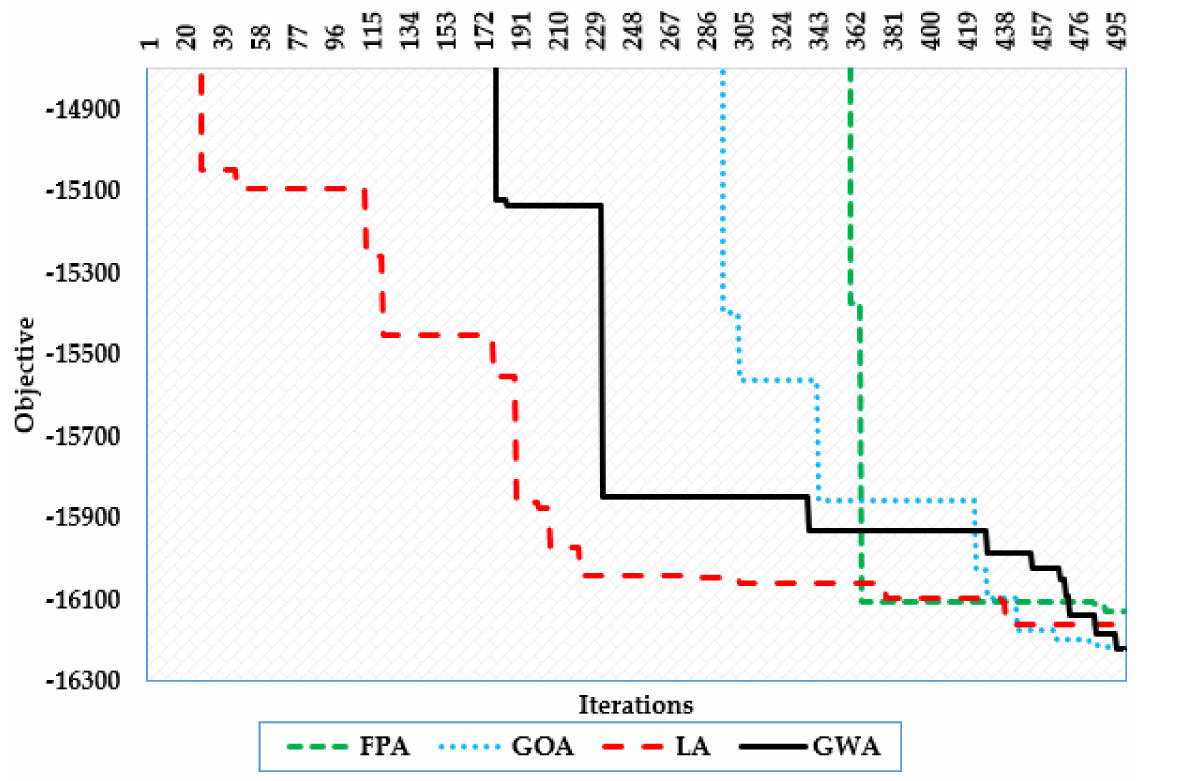
Figure 8. Best Convergence curves of GWA, FPA, LA, and GOA for TLSM design under second case. As shown, the GWA reaches the lowest value of 16,217.9 N for the flux saturation, while the FPA, LA, and GOA achieve levels of the force of 16,126.3 N, 16,217.8 N, and 16,161.23 N, respectively. With slot current of 781.77 A, slot height of 2.209 mm, magnet height of 36.195 mm, and slot thickness of 3.93 mm, the GWA was highly effective in locating the area of the spectrum with the least flux